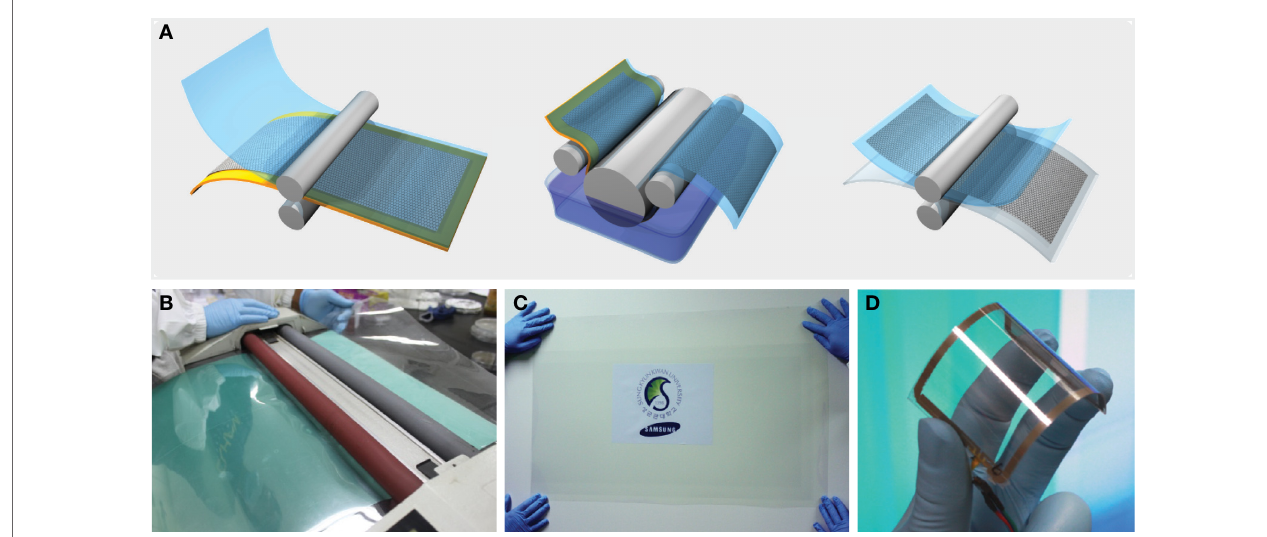
FiGURe 4 | (A) Schematic of the roll-to-roll production of graphene films grown on a copper foil. (B) Roll-to-roll transfer of graphene films from a thermal release tape to a PET film at 120°C. (C) A transparent large-area graphene film transferred on a 35 ″ PET sheet. (D) An assembled graphene/PET touch panel showing mechanical flexibility. Reproduced with permission of Bae et al. (2010). Copyright 2010, Nature